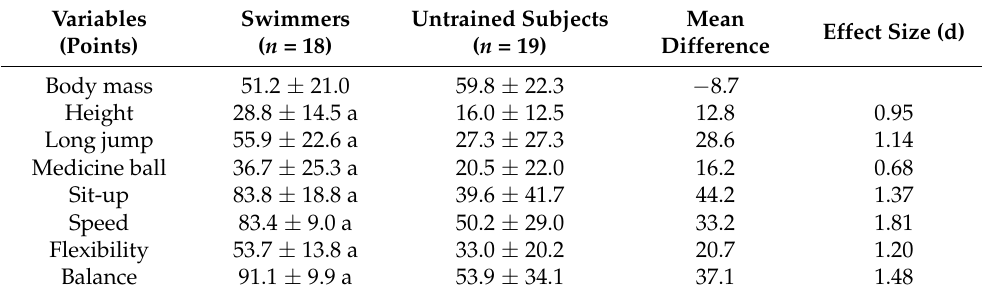
Table 2. Mean ( ± SD) and effect size percentile values for all variables of the Eurofit Special Test, body mass and height for trained swimmers and untrained